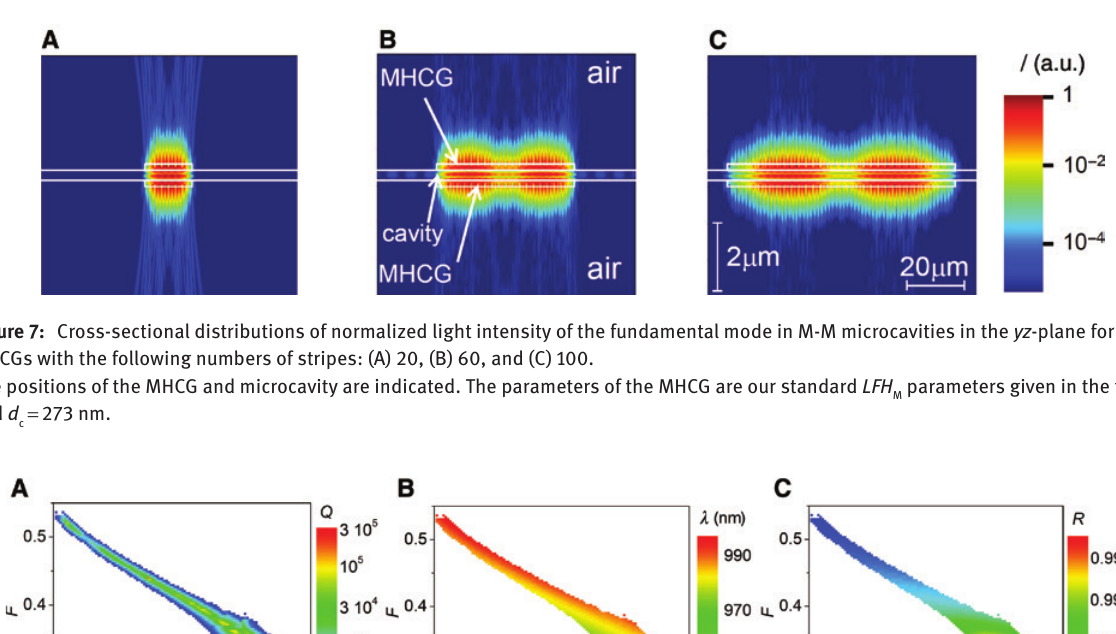
) for the fundamental 0-DO mode and for the λ values from (B) in the 0 = 163.9 nm. All are for an M-M M